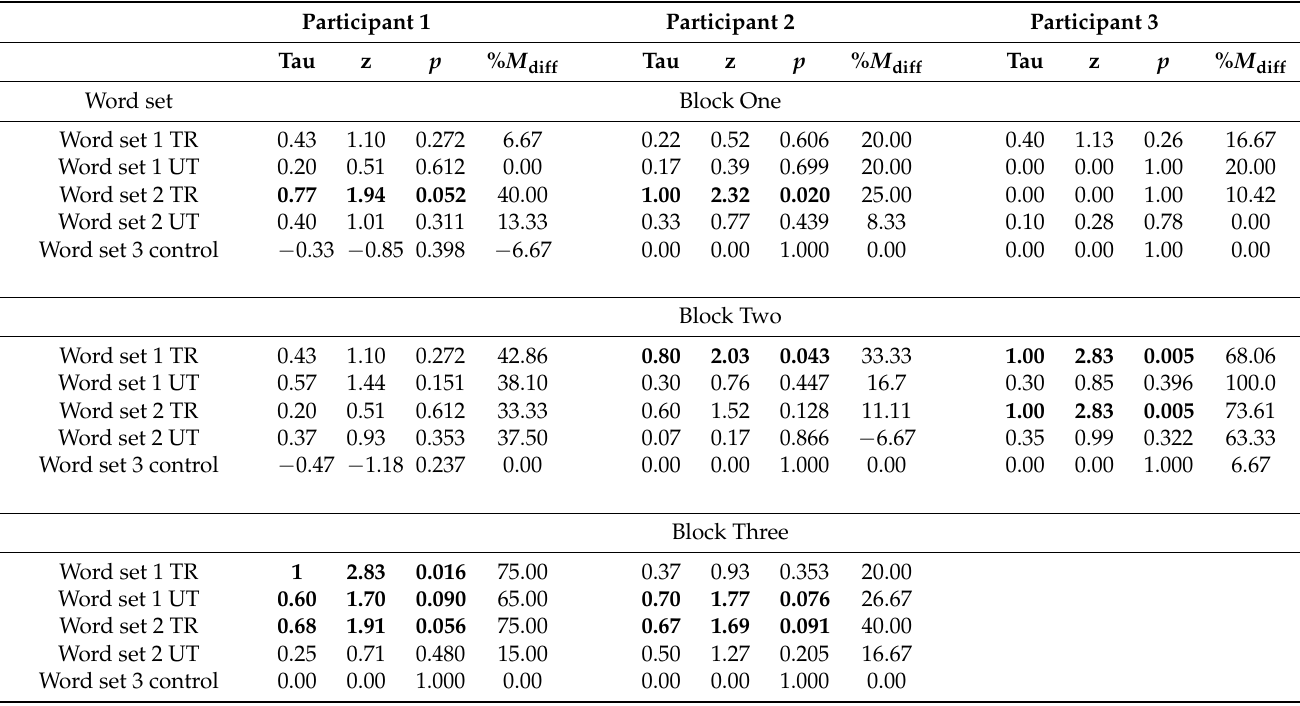
Table 5. Tau coefficient, z, p values and pre to post mean differences in percent for each word set for protophone scoring across Intervention Blocks.